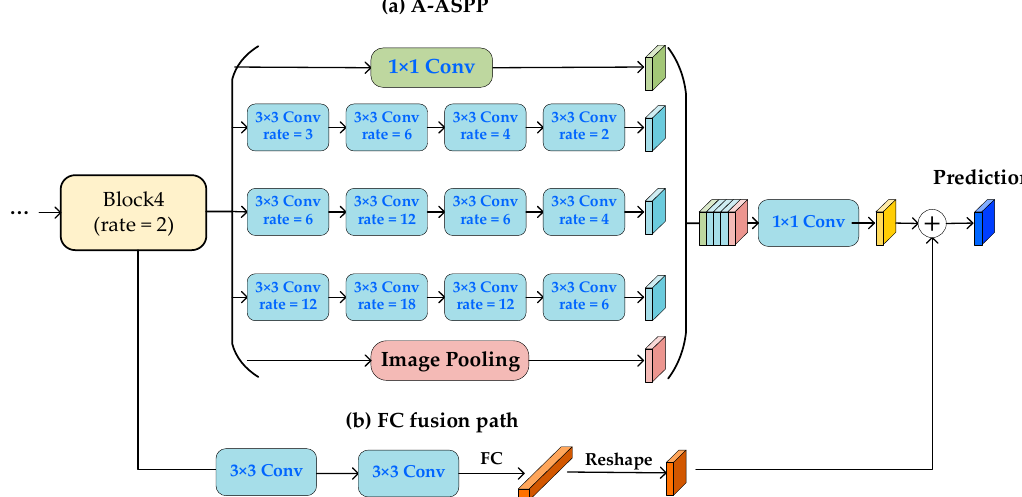
Figure 3. Schematic representation of the proposed architecture: Augmented ASPP network with Fully Convoluted fusion path, and post-processing stage. ( a ) Augmented Atrous Spatial Pyramid Pooling (A-ASPP) module with three parallel dilated convolution branches, each branch consists of four di ff erent expansion rate dilated convolution layers. ( b ) Fully connected (FC) fusion branch module consists of two convolution layers and one FC layer, our method fuse predictions from A-ASPP and FC outputs for better prediction.